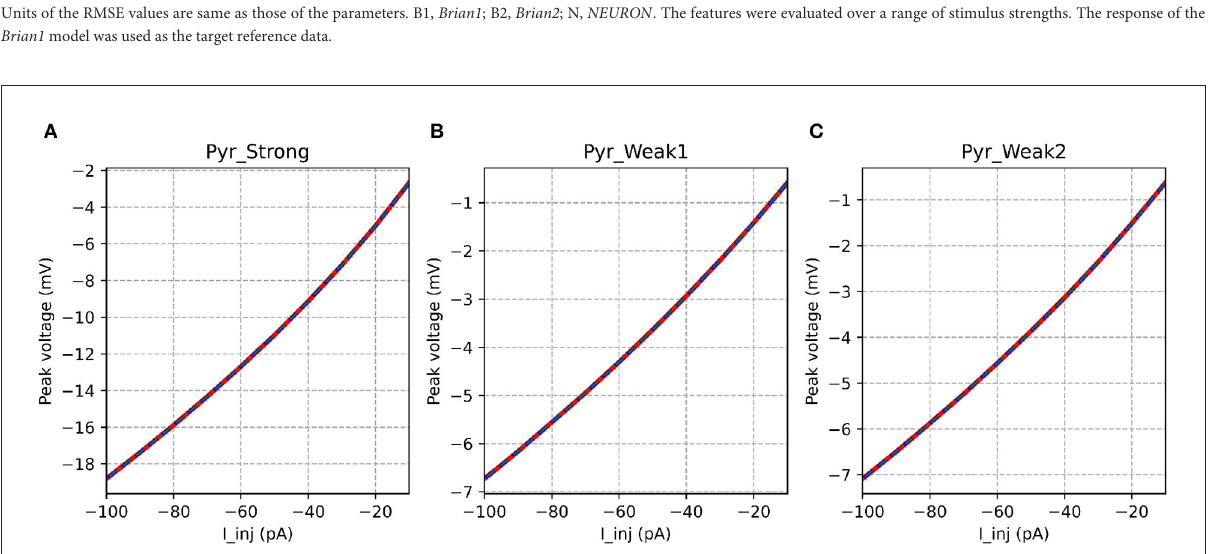
FIGURE6 I-V curves for the various implementations. All the implementations show identical response for all model variants. It is evident that the strongly adapting cell model has much higher excitability than the weakly adapting cell